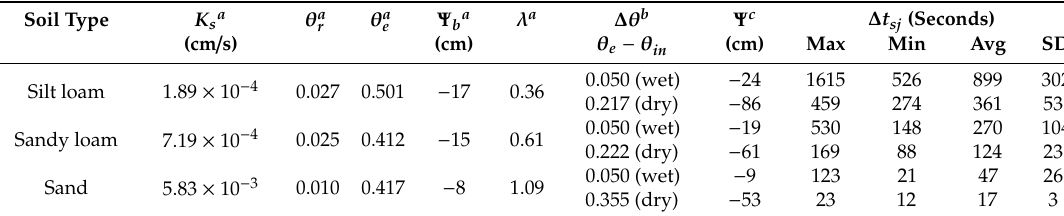
Table 2. The soil hydraulic properties for silt loam, sandy loam, and sand [38] and statistical summary of predicted ∆ t sj